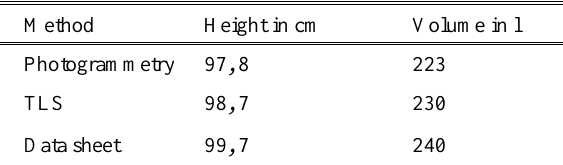
Table 2: Comparison of the measured volume from photogrammetry and laser scanning with the technical